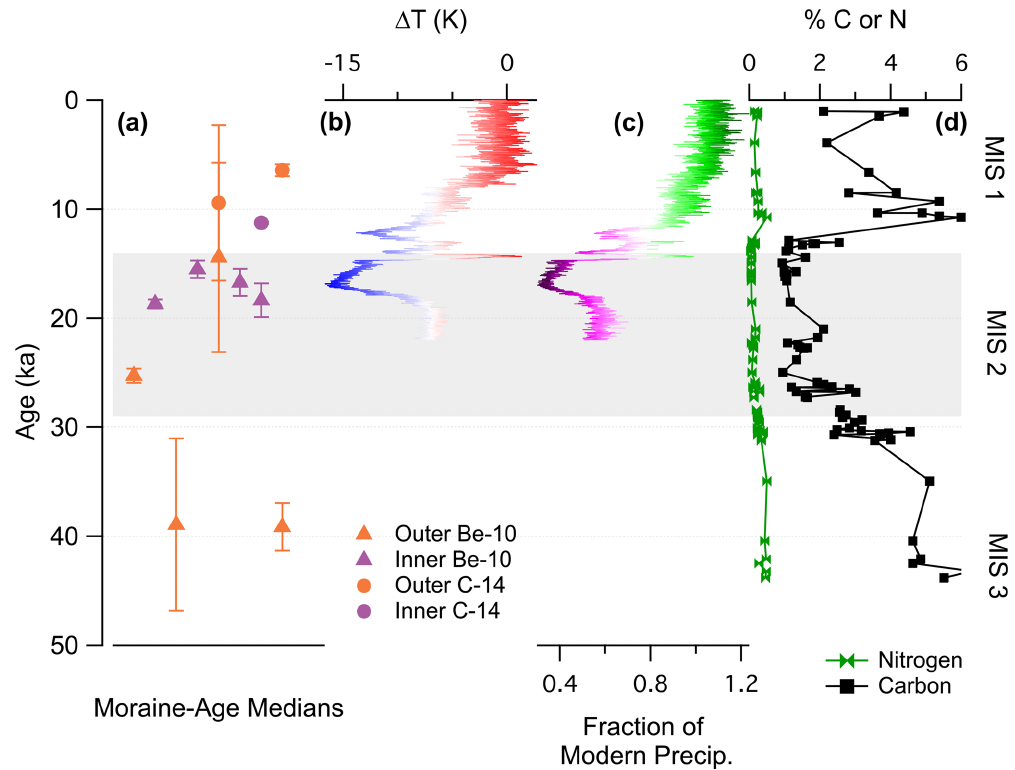
Figure 9. (a) Median ages of the inner and outer moraines for 10 Be and 14 C. (b, c) TRACE 21k surface temperature difference and change in precipitation relative to present for the Grey Hunter region (Liu et al., 2009). (d) Carbon and nitrogen content for the permafrost from the Yukon Territory (Mahony,